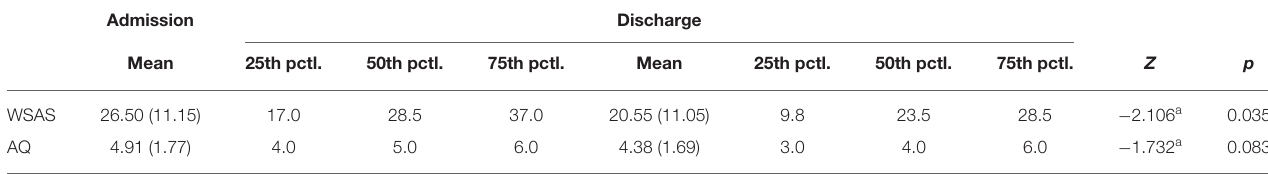
TABLE 2B | Changes in WSAS and AQ-10 pre-post measures for SU based on Wilcoxon signed-rank test.